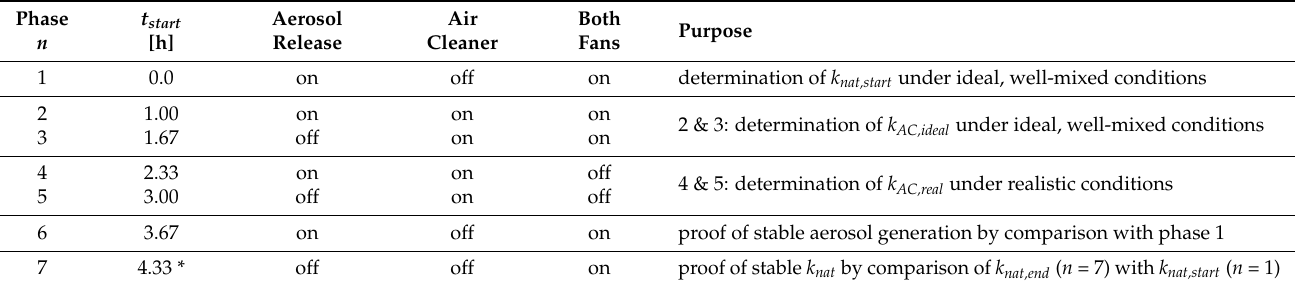
Table 7. Recommended testing procedure for the evaluation of air